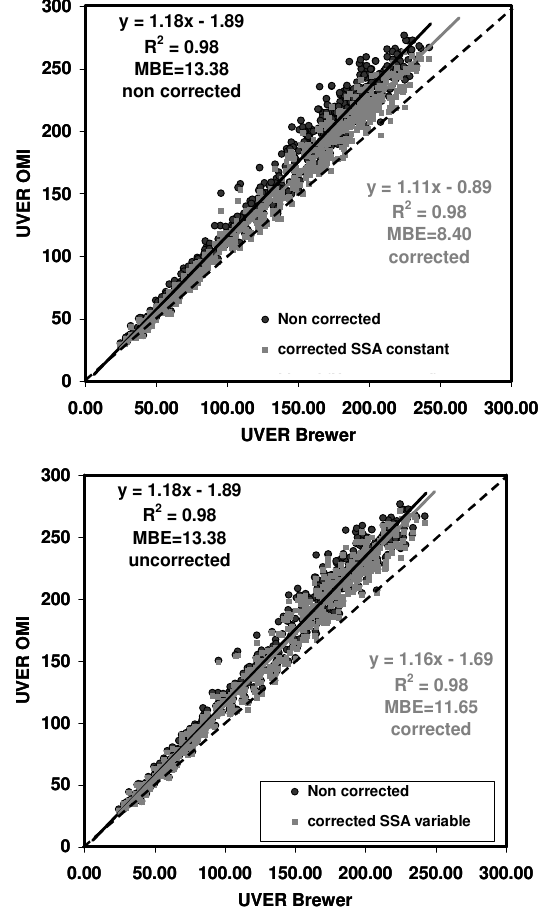
Fig. 10. Correlations and fits of OMI and Brewer irradiances with- out correction and for the two corrections: (a) first approach bases on SSA constant and (b) second approach based on SSA variable.